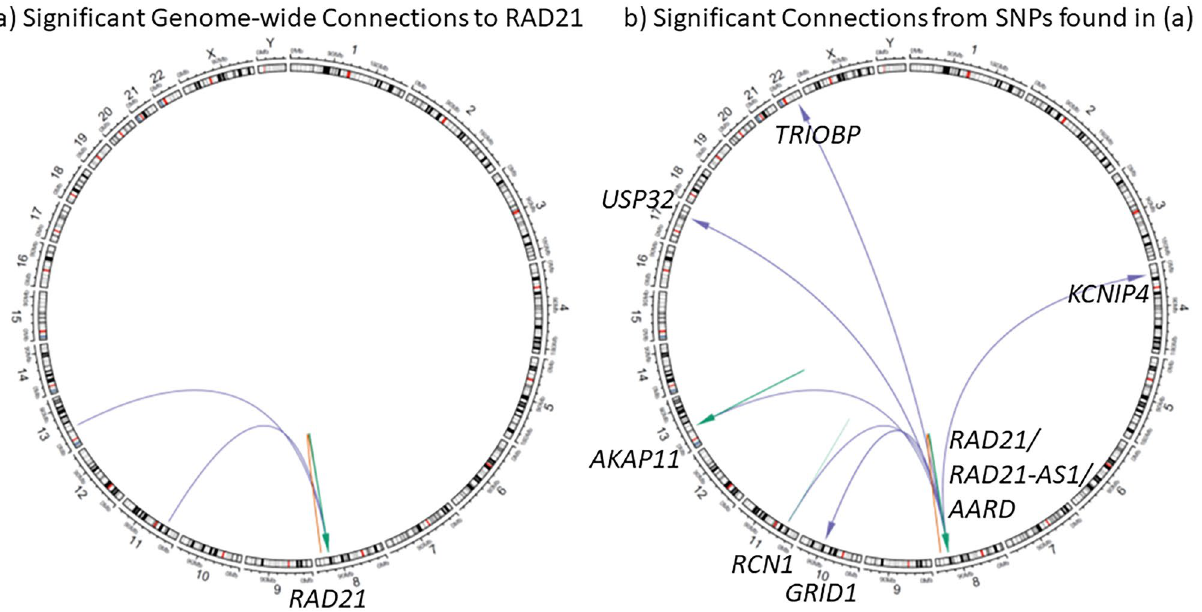
Figure 2. Circos plots showing the interactions and locations of the genes found for: ( a ) significant Genome- wide Connections to RAD21. ( b ) Significant Connections from SNPs found in ( a ). This resulted in the discovery of a hub of eight co-regulated genes: AARD , AKAP11 , GRID1 , KCNIP4 , RCN1 , TRIOBP , and USP32 . Color of the lines represents the distance of the connection, where green = cis , orange = trans -intrachromosomal, and purple = trans -interchromosomal. Arrows represent direction of regulation (SNP to